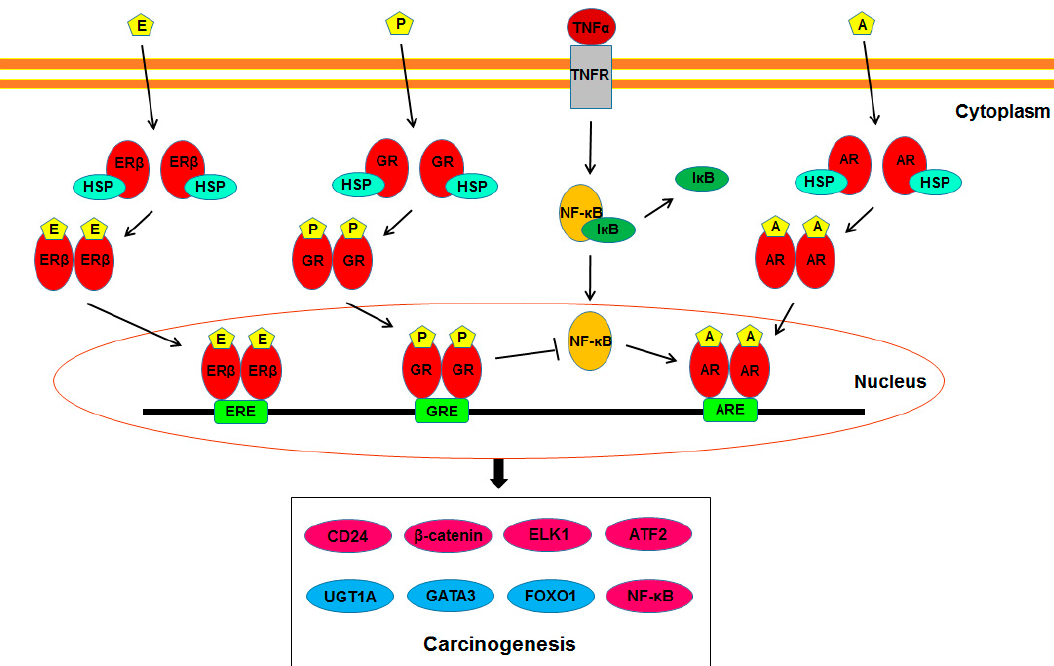
Figure 1. AR / ER β / GR signaling in urothelial carcinogenesis. A, androgen; AR, androgen receptor; ARE, androgen response element; E, estrogen; ER, estrogen receptor; ERE, estrogen response element; GR, glucocorticoid receptor; GRE, glucocorticoid response element; HSP, heat shock protein; P, prednisone; TNF, tumor necrosis factor; TNFR, tumor necrosis factor receptor.